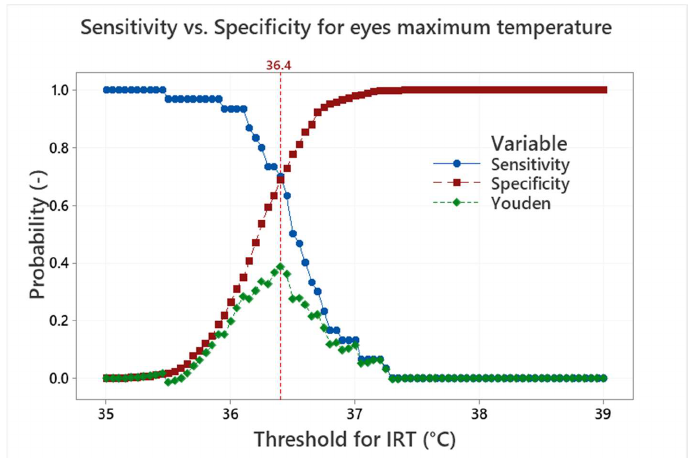
Figure 14. Sensitivity, specificity and Youden index curves for the maximum eyes temperature and the APT threshold of 36.5 °C.